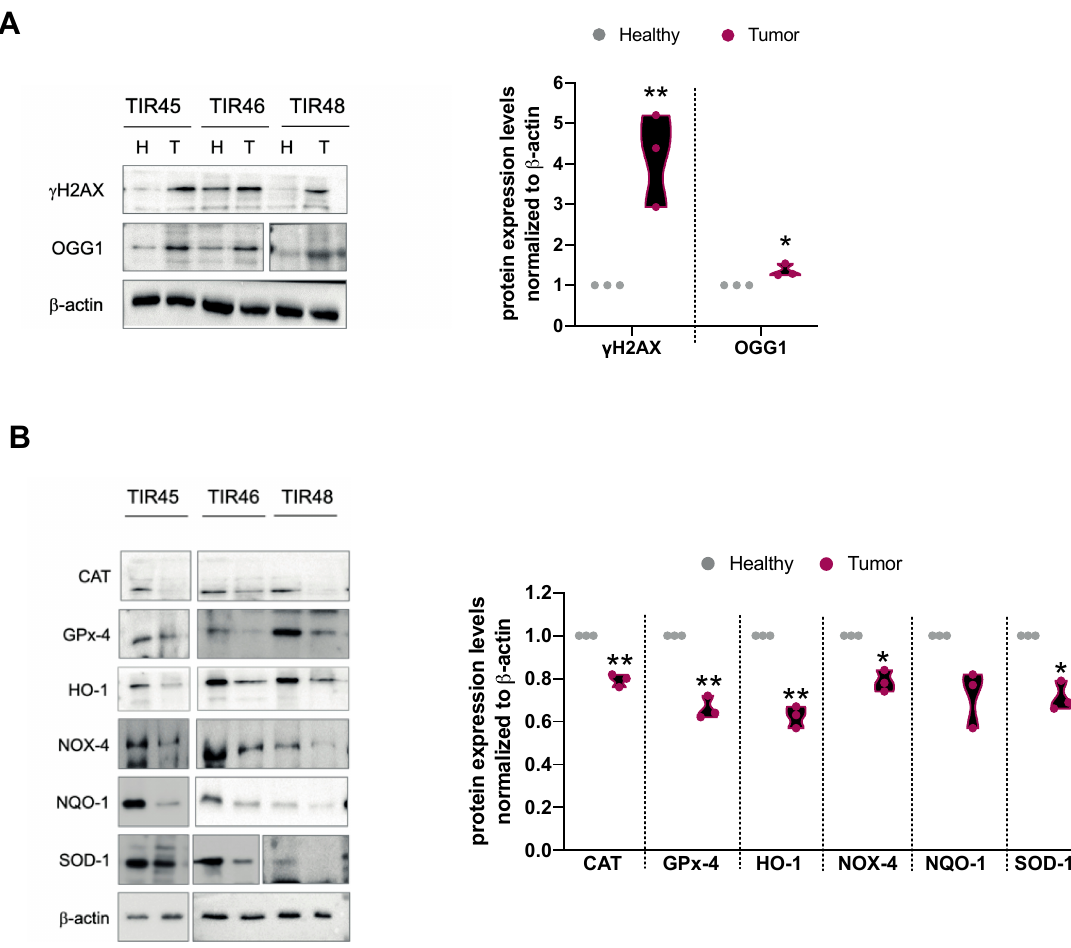
Figure 4. Oxidative stress and antioxidant response in PTCs. To evaluate the oxidative stress levels and the antioxidant response, protein lysates obtained from patients TIR45, TIR46, and TIR48 were analyzed by immunoblot. ( A ) Representative immunoblots are reported together with the relative quantification of pSer139-H2AX ( γ H2AX) and OGG1 proteins expression normalized to β -actin. Violin plots represent the mean value ± SD of the expression of each protein normalized to the healthy counterparts, in the three analyzed patients (Student’s t-test, * p < 0.05; ** p < 0.01 with respect to healthy lobes). ( B ) Representative immunoblots are reported together with the relative quantification of CAT, GpX-4, HO-1, NOX-4, NQO-1, and SOD-1 proteins expression normalized to β -actin. Violin plots represent the mean value ± SD of expression of each protein normalized to the healthy counterparts, in the three analyzed patients (Student’s t-test, * p < 0.05; ** p < 0.01 with respect to healthy lobes).